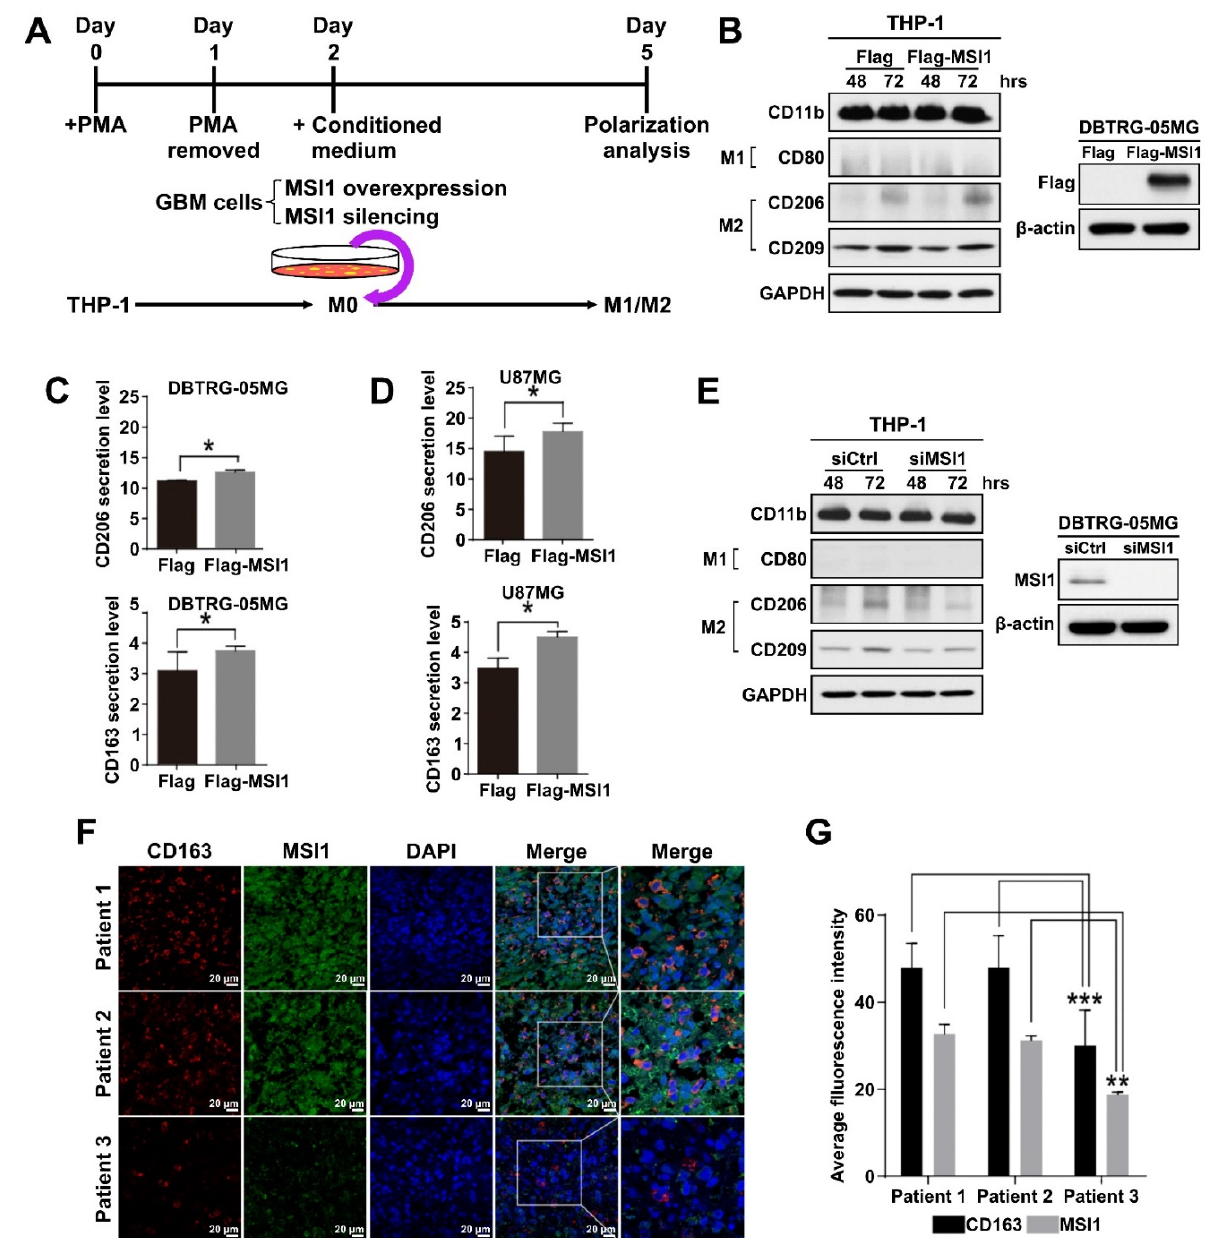
Figure 2. THP-1-derived macrophages are polarized into the M2 state in the MSI1-dependent manner. ( A ) Schematic diagram of the experimental design to test the effect of the GBM cell-conditioned media on macrophage polarization. ( B ) Left panel: immunoblotting analysis of the expression of the indicated M1 and M2 markers in the THP-1-derived macrophages treated with the media conditioned by the DBTRG-05MG cells transfected with Flag–MSI1 and the control Flag-only plasmid (Flag) for 48 and 72 h. Right panel: immunoblotting analysis of the expression of Flag–MSI1 in transfected DBTRG-05MG cells. GAPDH and β -actin were used as loading controls. ( C , D ) ELISA analysis of the secretion of CD206 and CD163 by the THP-1-macrophages treated with the media conditioned by the DBTRG-05MG ( C ) and U87MG ( D ) cells transfected with Flag-MSI and the control Flagonly plasmid (Flag). Mean values are shown, n = 3, SD—error bars, * p < 0.05 (Student’s t -test). ( E ) Immunoblotting analysis of the expression of the indicated M1 and M2 markers in the THP-1-derived macrophages treated with the media conditioned by the DBTRG-05MG cells subjected to MSI1 knockdown. The right panel shows immunoblotting analysis of MSI1 expression upon knockdown. ( F ) Immunofluorescent staining of CD163 and MSI1 in cross-sections of three patients’ GBM samples, nuclei stained with DAPI. ( G ) Quantification of the fluorescent signal in ( F ) was achieved by ImageJ measuring of the staining intensity with five views measured for each sample. Mean values are shown, n = 3, ** p < 0.01, *** p < 0.05 (Student’s t -test).